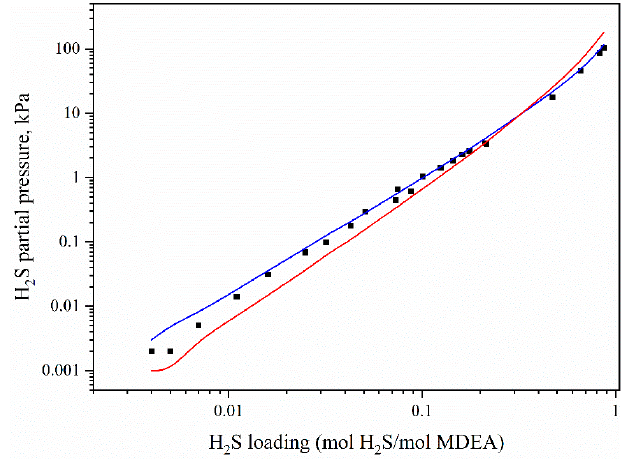
Figure 7. Comparison of the calculated data in the reference and in this work for the H 2 S–H 2 O–